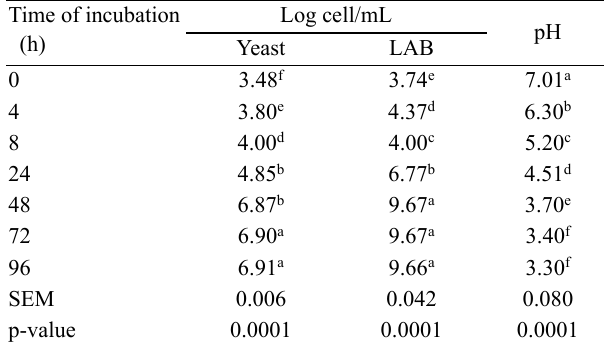
Table 1. Yeast and LAB populations in fermented milk Time of incubation